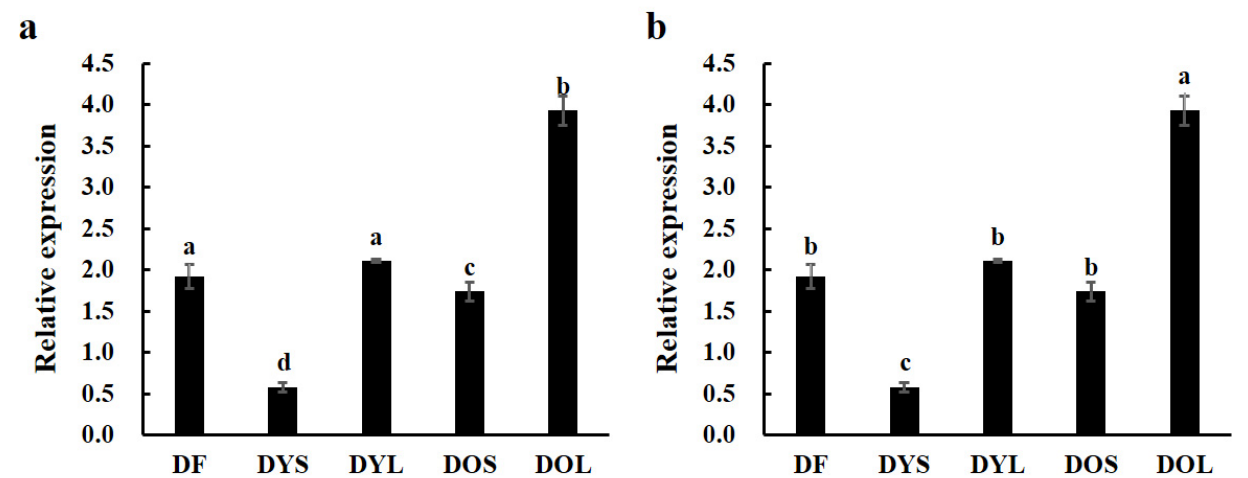
Figure 2. Expression pattern analysis of ZjTCP16 in response to JWB phytoplasma. Different tissues of healthy ( a ) and JWB-phytoplasma-infected ( b ) jujube were sampled for RNA extraction and qRT-PCR. Expression levels of ZjTCP16 in different tissues of healthy and JWB-infected jujube trees, including flowers (HF/DF), young stems (HYS/DYS), young leaves (HYL/DYL), old stems (HOS/DOS) and old leaves (HOL/DOL). Different letters above the bars indicated significant difference ( p < 0.05) as obtained by one-way ANOVA.